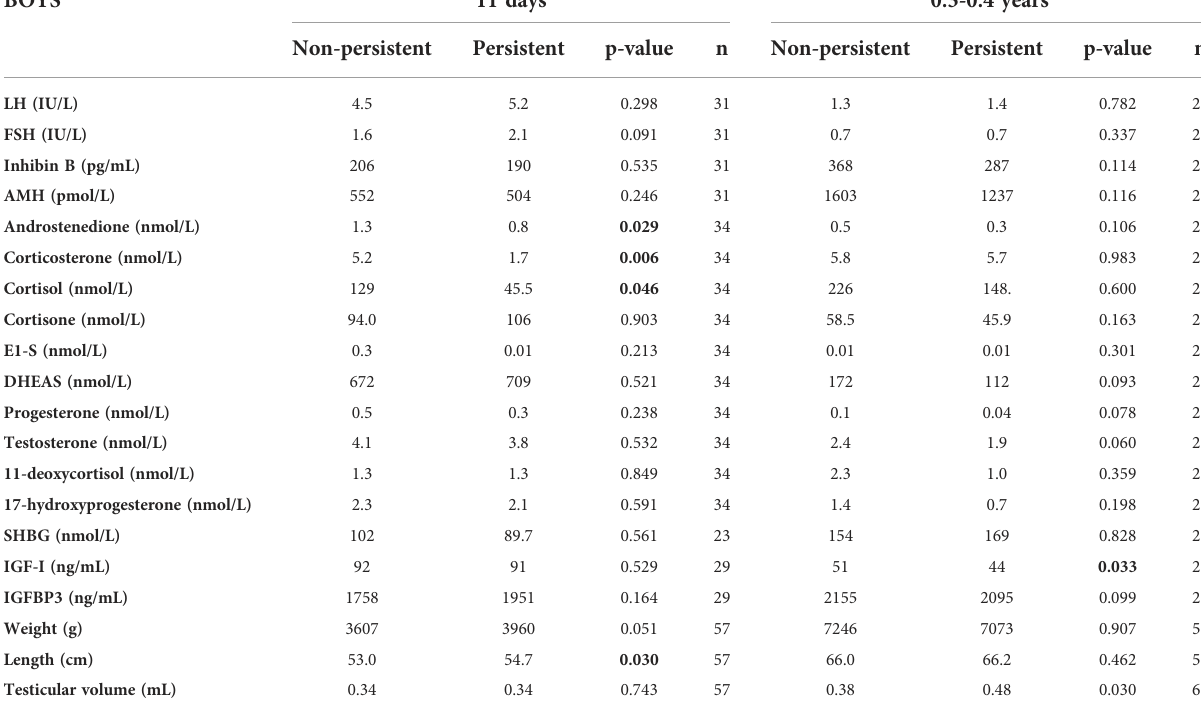
TABLE 1 Median hormone concentrations and anthropometric measures and total counts (n) in boys with persistent and non-persistent breast tissue in infancy at the initial exam (median age 11 days) and at the exam between 0.3-0.4 years of age. BOYS 11 days